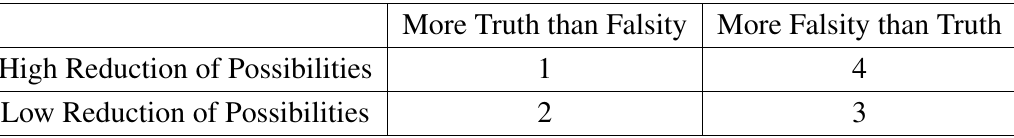
Table 12. Possibility reduction and truth/falsity